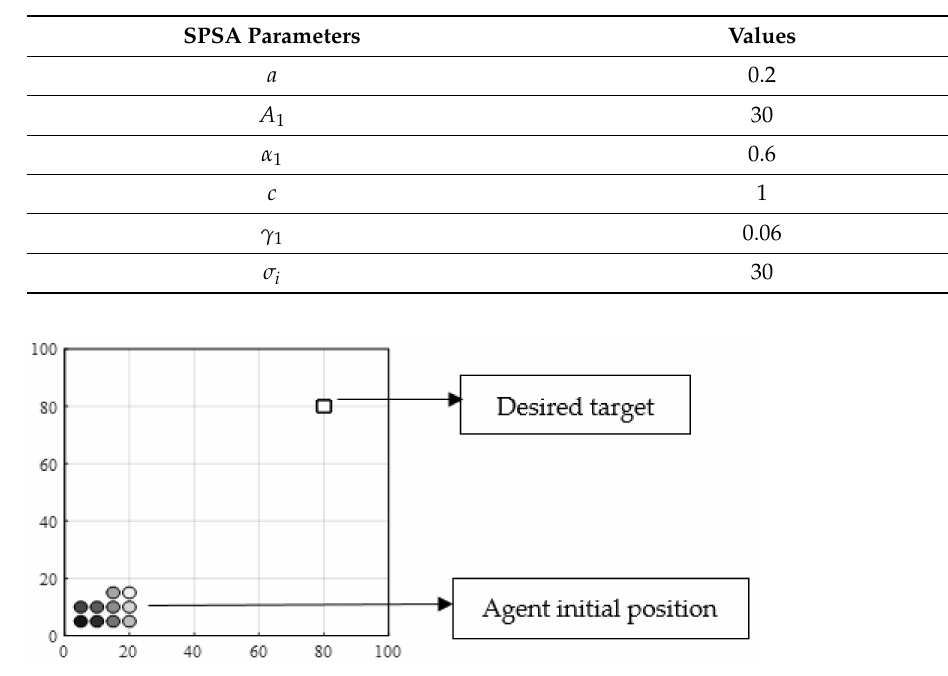
Table 2. Optimal simultaneous perturbation stochastic algorithm (SPSA) and event-triggered (ET) parameter settings for the broadcast event-triggered (BET) controller.